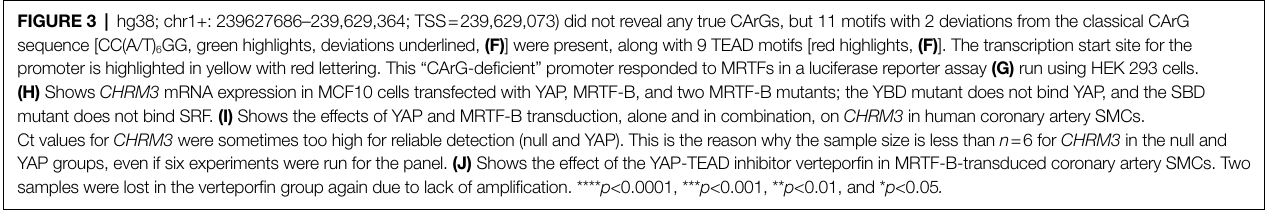
FIGURE 3 | hg38; chr1+: 239627686–239,629,364; TSS = 239,629,073) did not reveal any true CArGs, but 11 motifs with 2 deviations from the classical CArG sequence [CC(A/T) 6 GG, green highlights, deviations underlined, (F) ] were present, along with 9 TEAD motifs [red highlights, (F) ]. The transcription start site for the promoter is highlighted in yellow with red lettering. This “CArG-deficient” promoter responded to MRTFs in a luciferase reporter assay (G) run using HEK 293 cells. (H) Shows CHRM3 mRNA expression in MCF10 cells transfected with YAP, MRTF-B, and two MRTF-B mutants; the YBD mutant does not bind YAP, and the SBD mutant does not bind SRF. (I) Shows the effects of YAP and MRTF-B transduction, alone and in combination, on CHRM3 in human coronary artery SMCs. Ct values for CHRM3 were sometimes too high for reliable detection (null and YAP). This is the reason why the sample size is less than n = 6 for CHRM3 in the null and YAP groups, even if six experiments were run for the panel. (J) Shows the effect of the YAP-TEAD inhibitor verteporfin in MRTF-B-transduced coronary artery SMCs. Two samples were lost in the verteporfin group again due to lack of amplification. **** p <0.0001, *** p <0.001, ** p <0.01, and * p <0.05